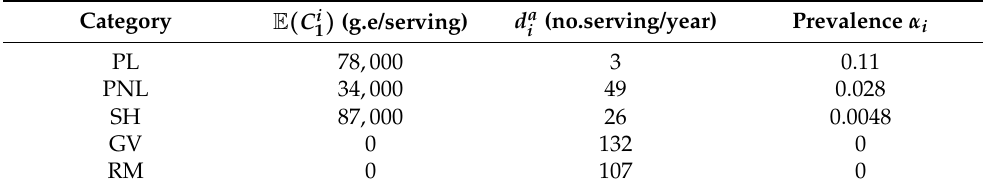
) , meaning λ − 1 , the average number of 1 i